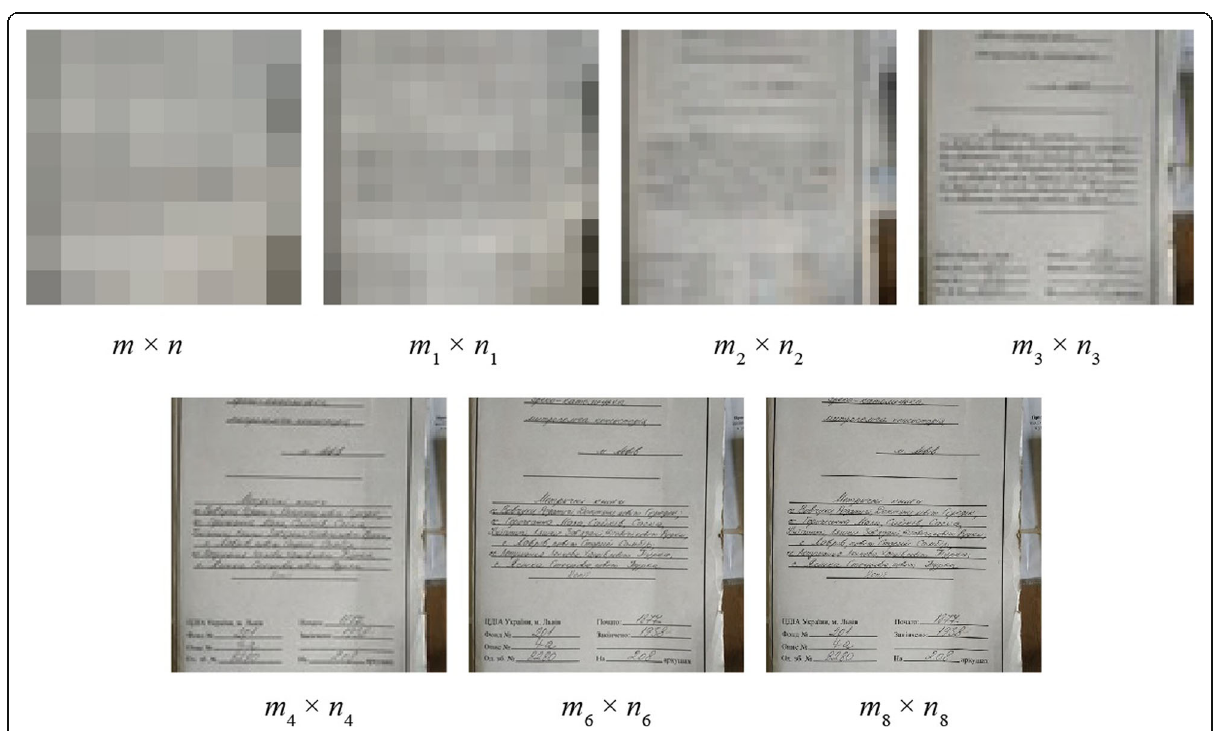
Fig. 3 Images with different virtual pixel sizes